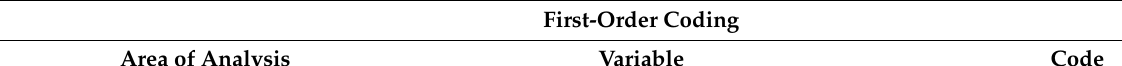
Table 2. Thematic matrix applied in accordance with the area of analysis.